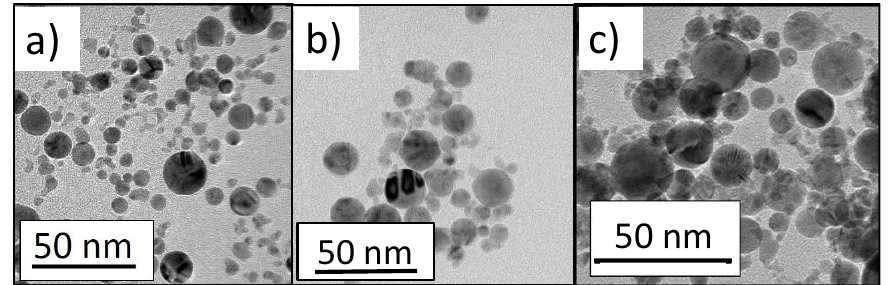
Figure 1. Transmission electron microscopy image of: ( a ) Pt, ( b ) Pd and ( c ) Pt 80 Pd 20 nanoparticles.